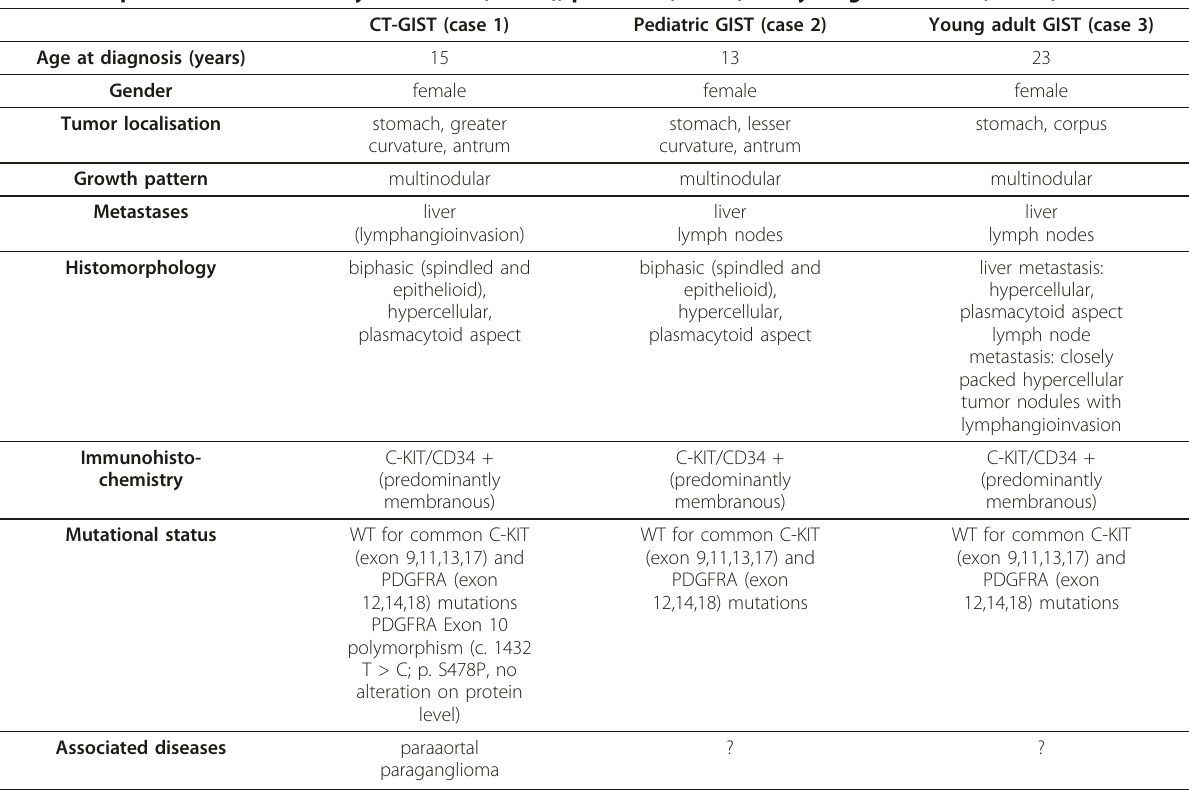
Table 1 Comparison between Carney triad GIST (case 1), pediatric (case 2) and young adult GIST (case